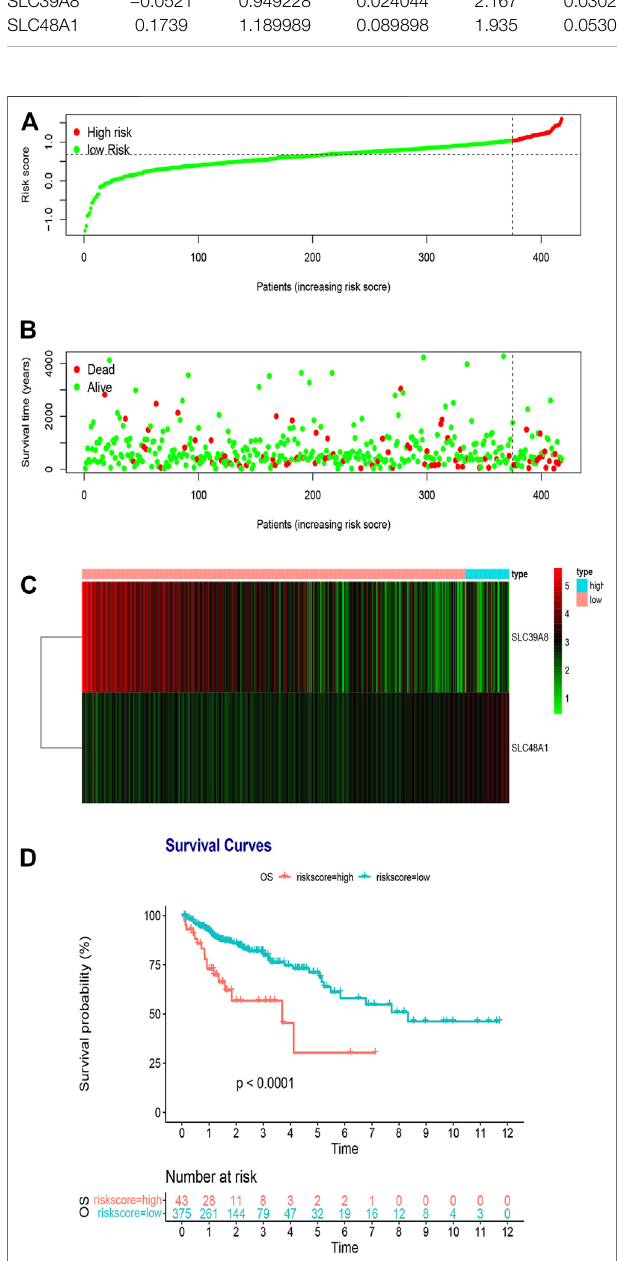
FIGURE 3 | Risk score analysis of the two-gene prognostic model in the TCGA training cohort. (A) Survival differences between high- and low-risk groups. (B) Dot plots comparing outcomes of subjects in the high- and low-risk groups. (C) Heat map for gene expressions in the high- and low-risk groups. (D) Kaplan Meier survival analysis of all patients with COAD in the high- and low-risk groups.